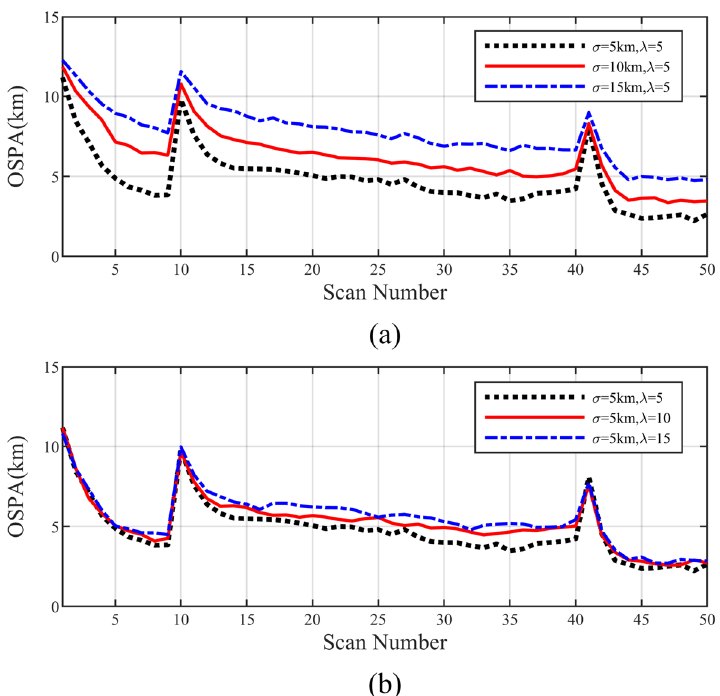
Fig. 10 OSPA metric with various parameters. a Various range variances, b Various clutter numbers